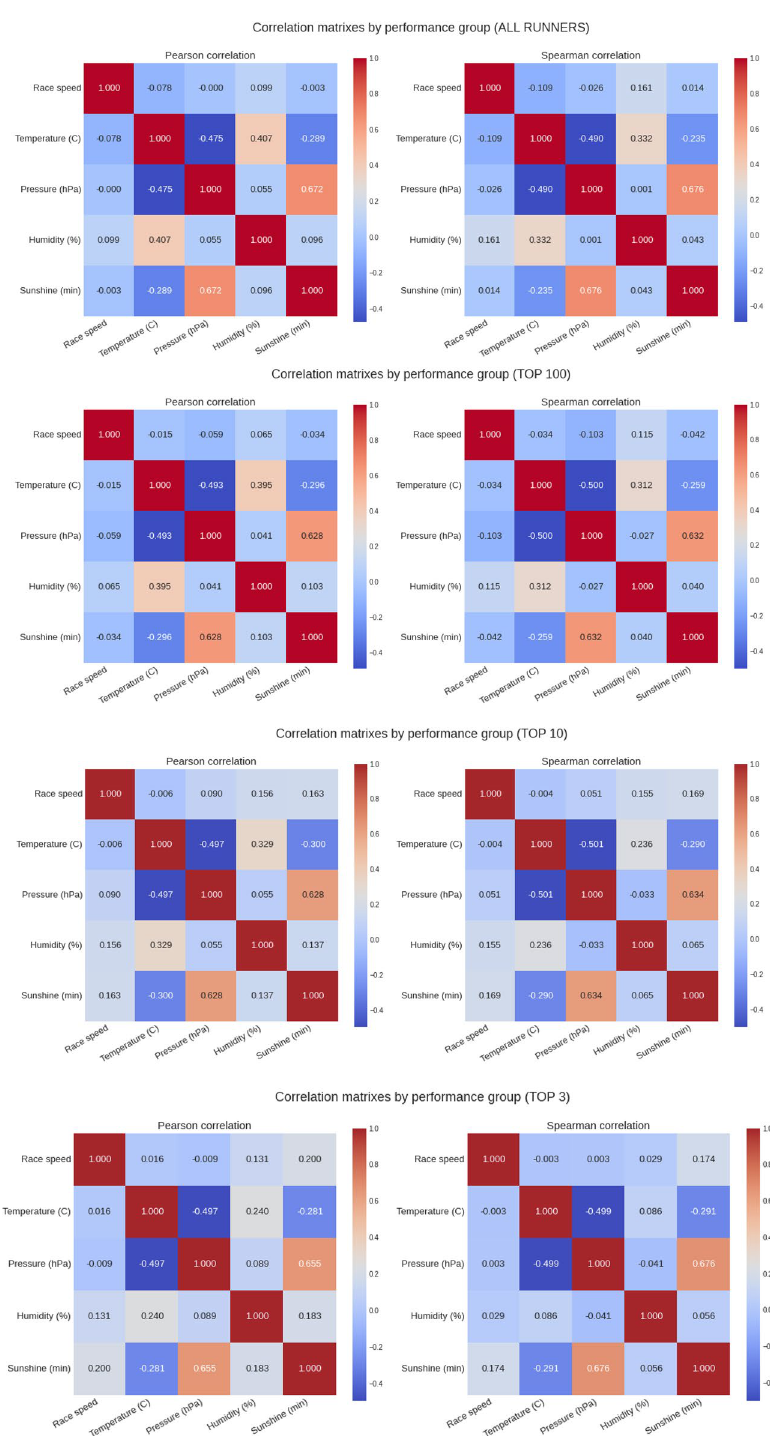
Figure 6. Correlation matrixes (running speed versus weather conditions) by performance